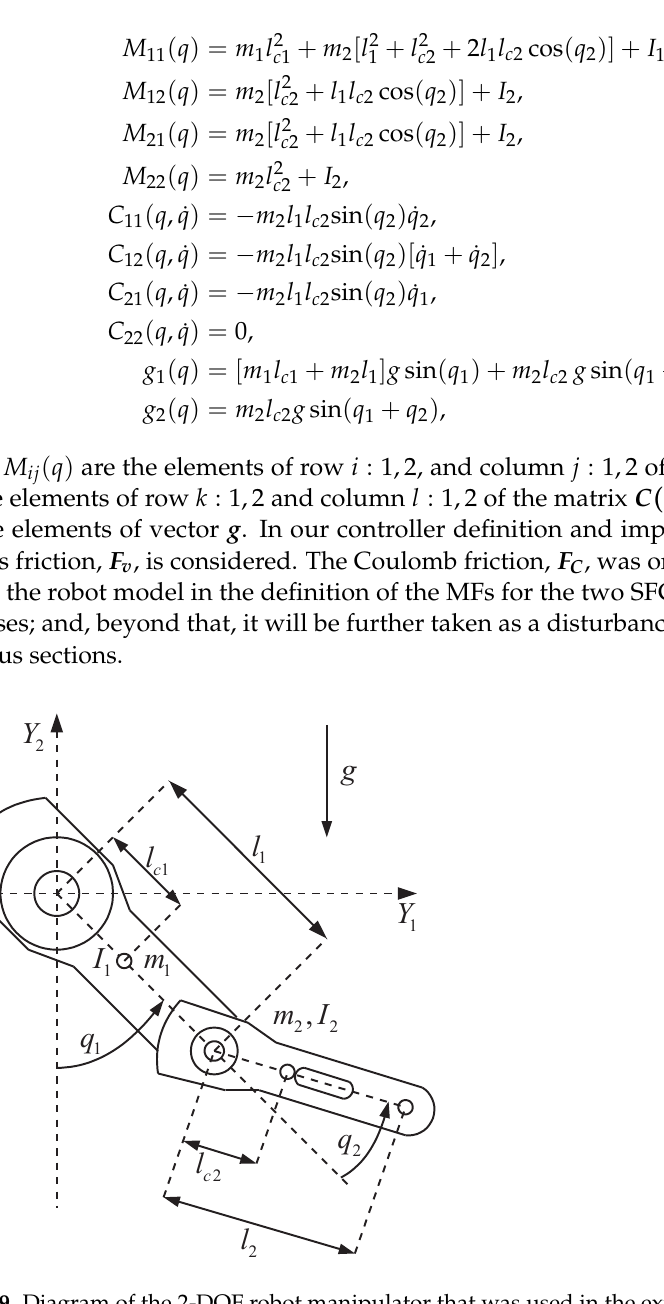
Figure 9. Diagram of the 2-DOF robot manipulator that was used in the